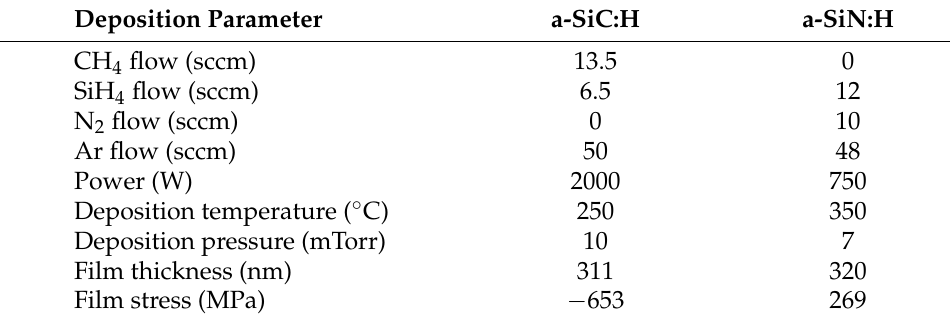
Table 4. Deposition and film parameters of a-SiC:H and